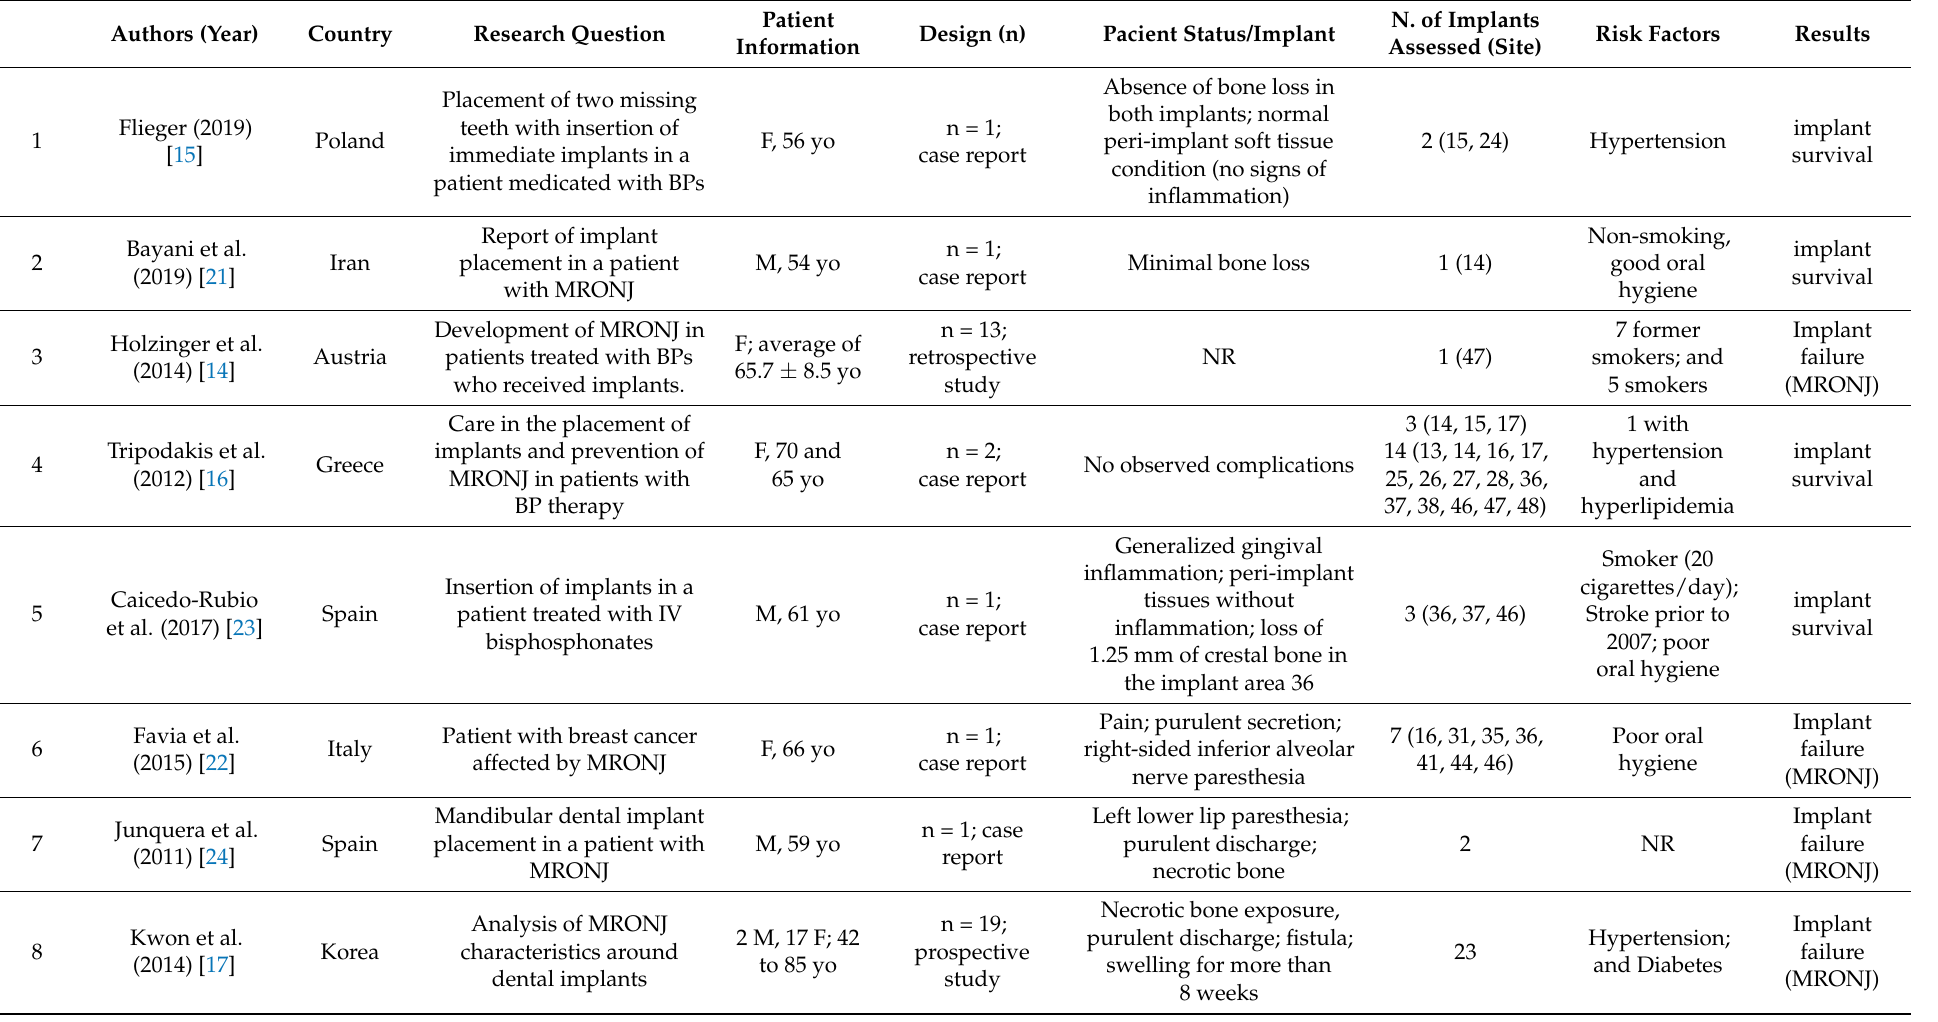
Table 3. Characteristics of the patients and implants